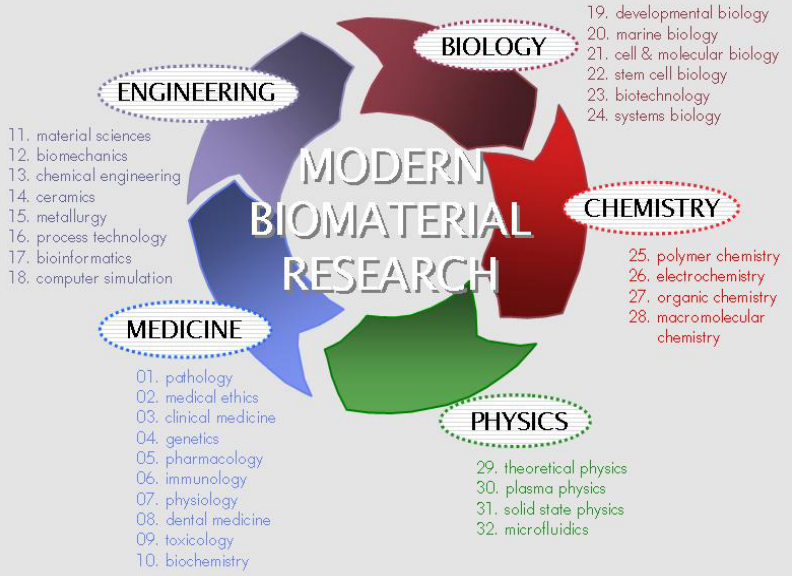
Figure 3. Disciplines involved in modern biomaterial research. The representation is based on the description made by bioengineer J. Kirkpatrick [39] (Modified from